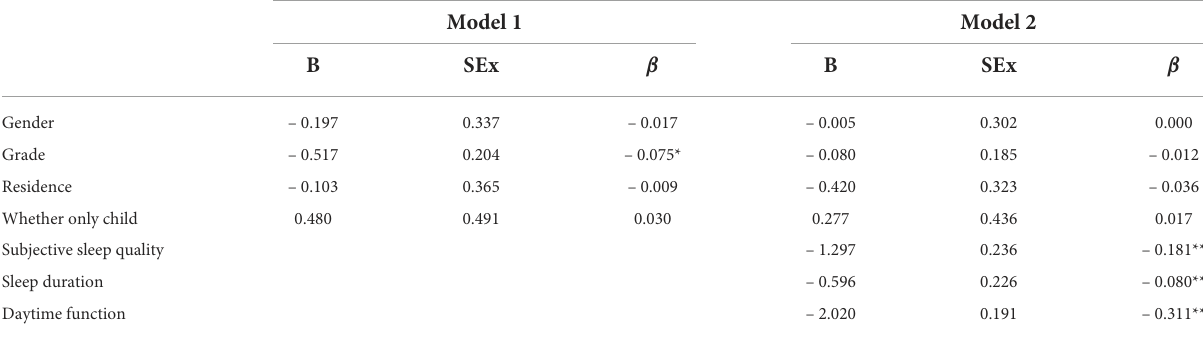
TABLE 3 Regression results of sleep quality and life satisfaction ( n = 1127).